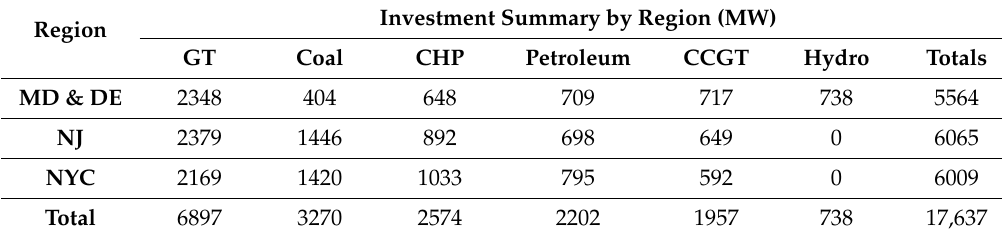
Nuclear Figure 5. Baseline Model Dispatch Summary.